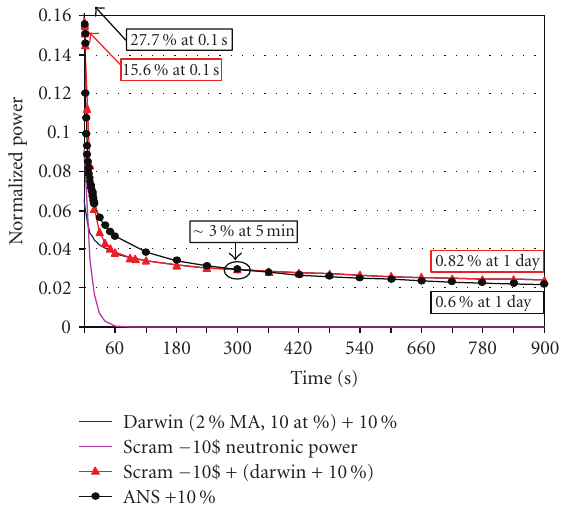
Figure 4: GFR 2400 MWth core decay heat evolution with time.